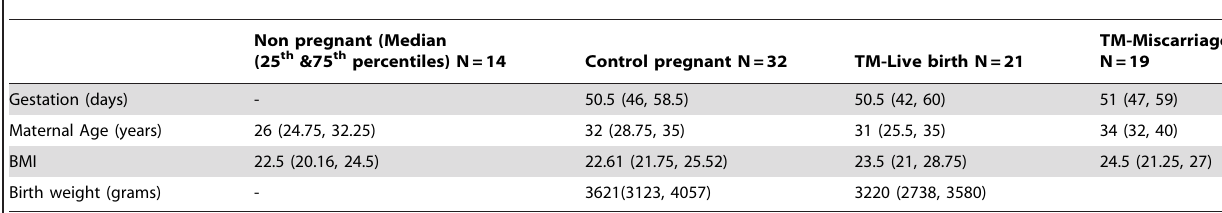
Table 1. Demographic details of the participants in the study given as median and interquartile range (25 th , 75 th percentiles).